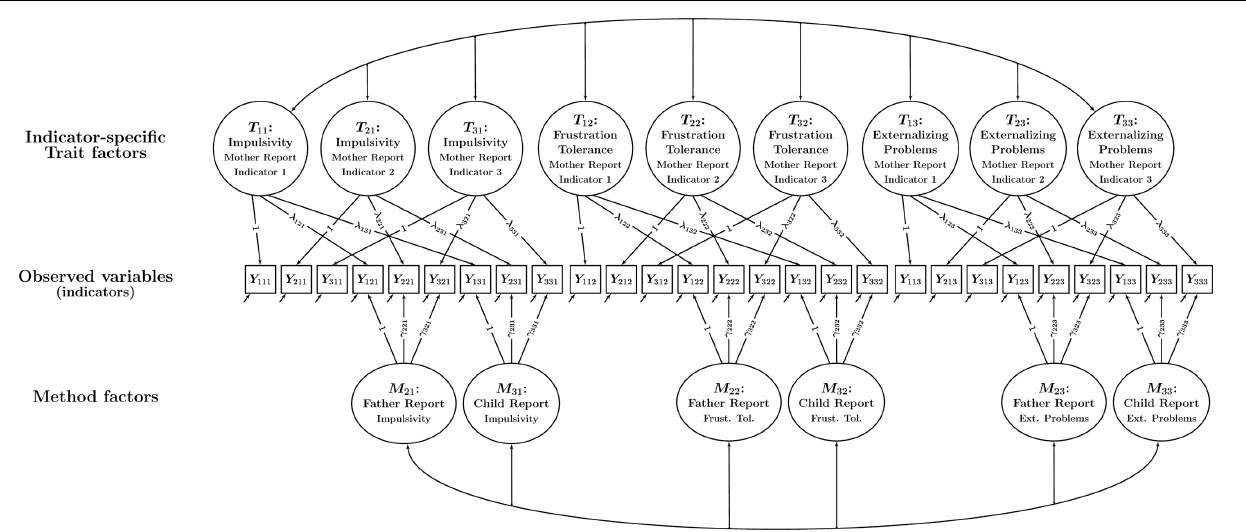
FIGURE 4 | Path diagram illustrating a CT-C( M – 1) model with indicator-specific trait factors. In the example, there are three traits and three methods. Each trait-informant combination is measured by three observed variables (indicators) Y imt ( i = indicator, m = method or type of informant, t = trait). Trait factors T it are shown at the top, trait-specific method factors M mt at the bottom of the figure. Observed variables with the same index i and t (but different method index m ) load onto the same indicator-specific trait factor T it . The parameters λ imt and γ imt denote trait and method factor loadings, respectively. All trait factors can be correlated and all method factors can be correlated as indicated by double-headed arrows. Correlations between trait and method factors pertaining to the same trait are not